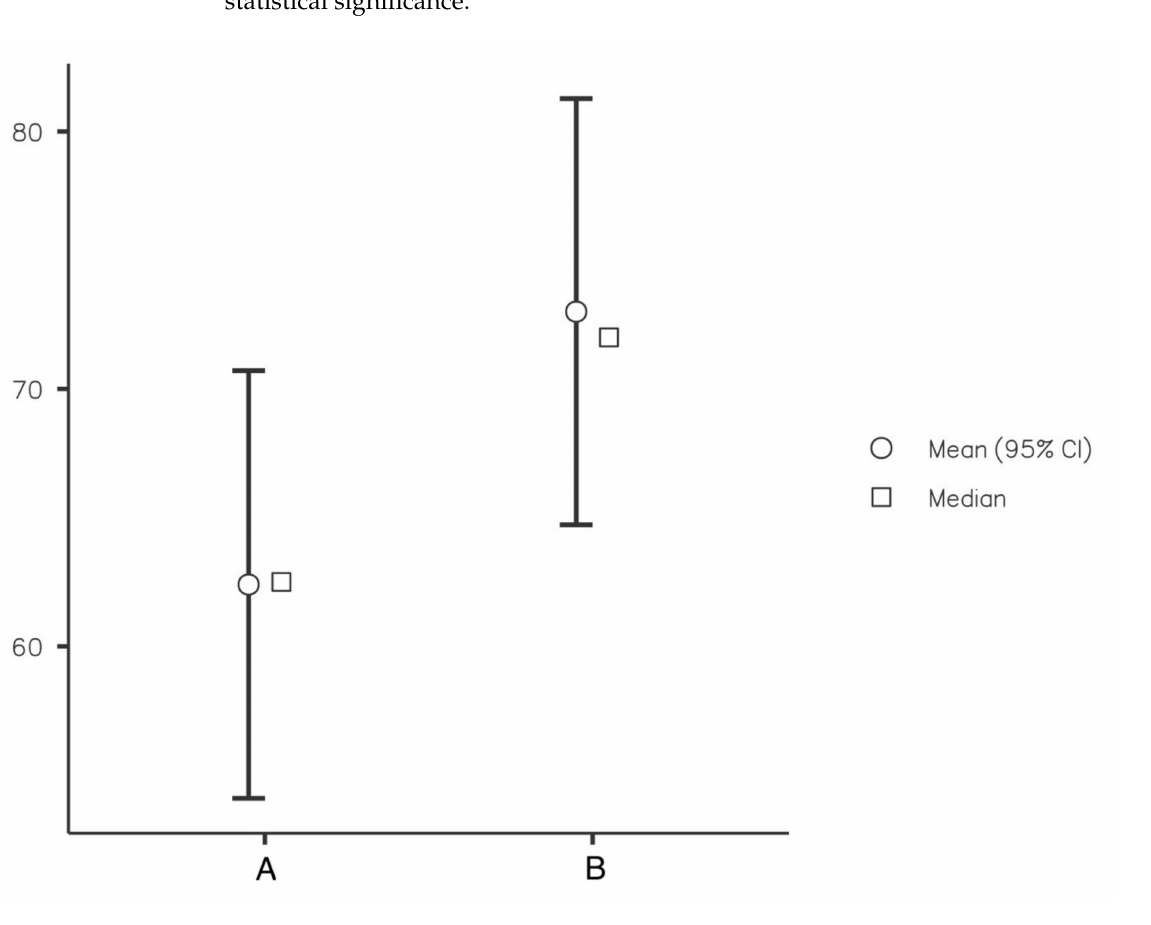
Figure 4. CPCHILD score at the 6-week follow-up for spica cast (A) and foam splint